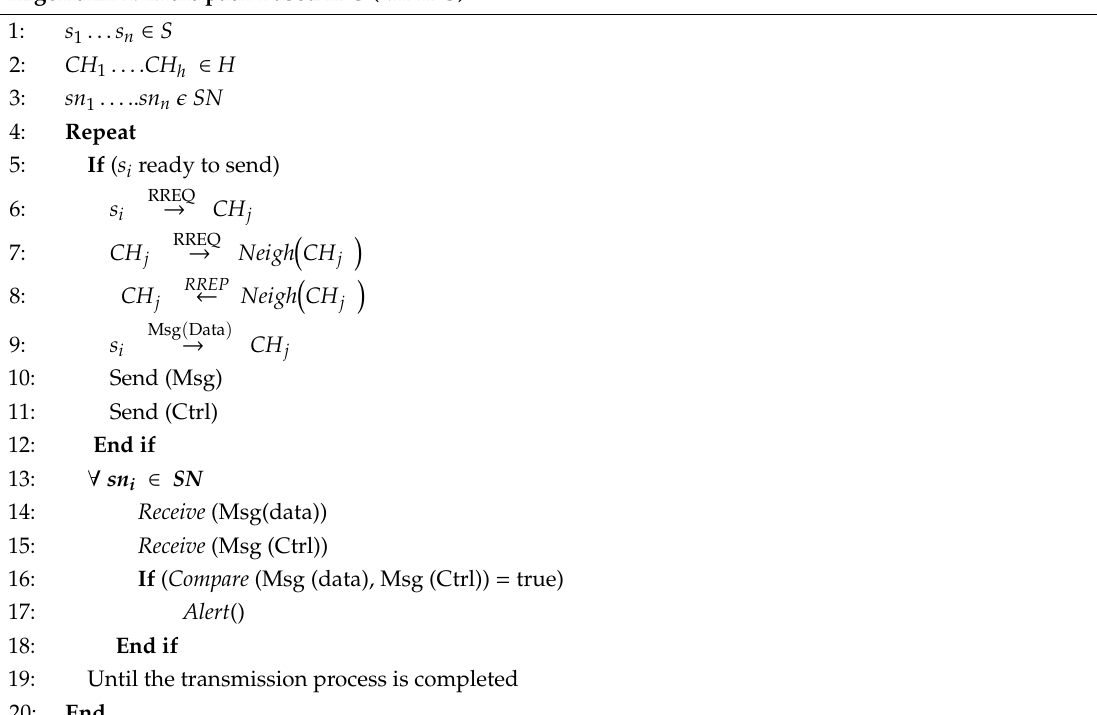
Algorithm 1. Multipath-Based IDS